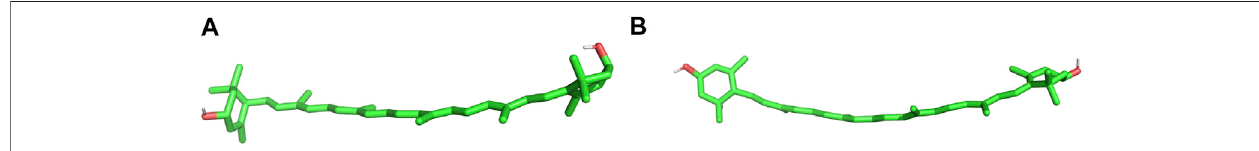
FIGURE 6 | 3D images of lutein in water. The ε -ring (on the left) torsion in the (A) – 50 ° and (B) 130 ° conformations. In both conformations the ε -rings are almost perpendicular to the polyene chain and, at the same time, their planes are mutually